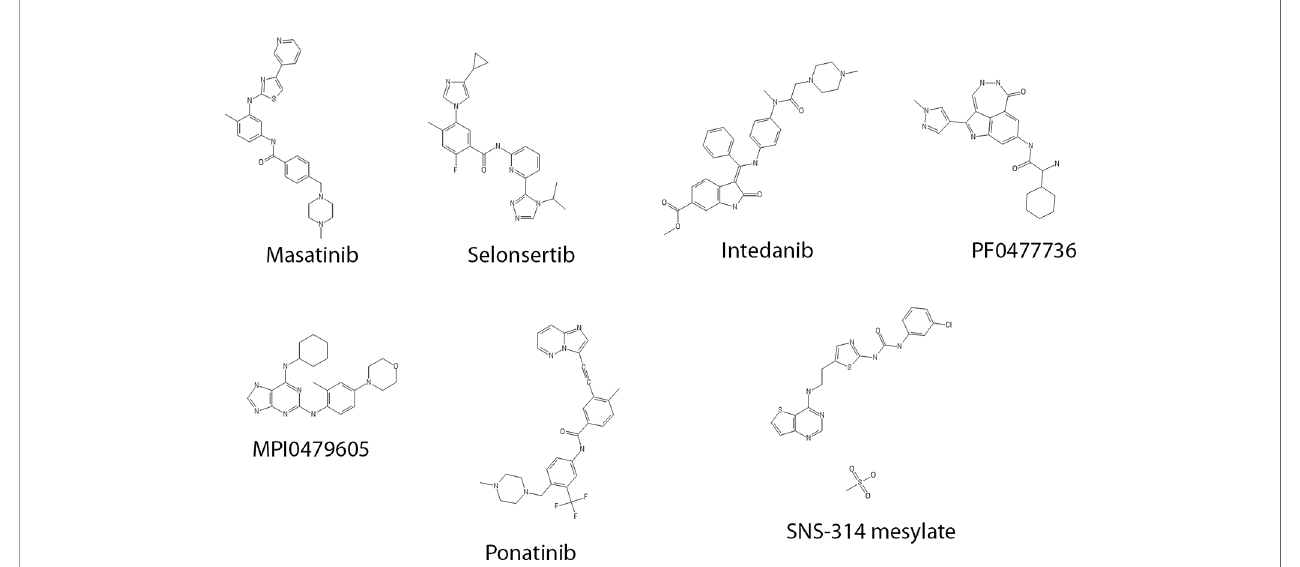
FIGURE 2 | Structure of the selected kinase